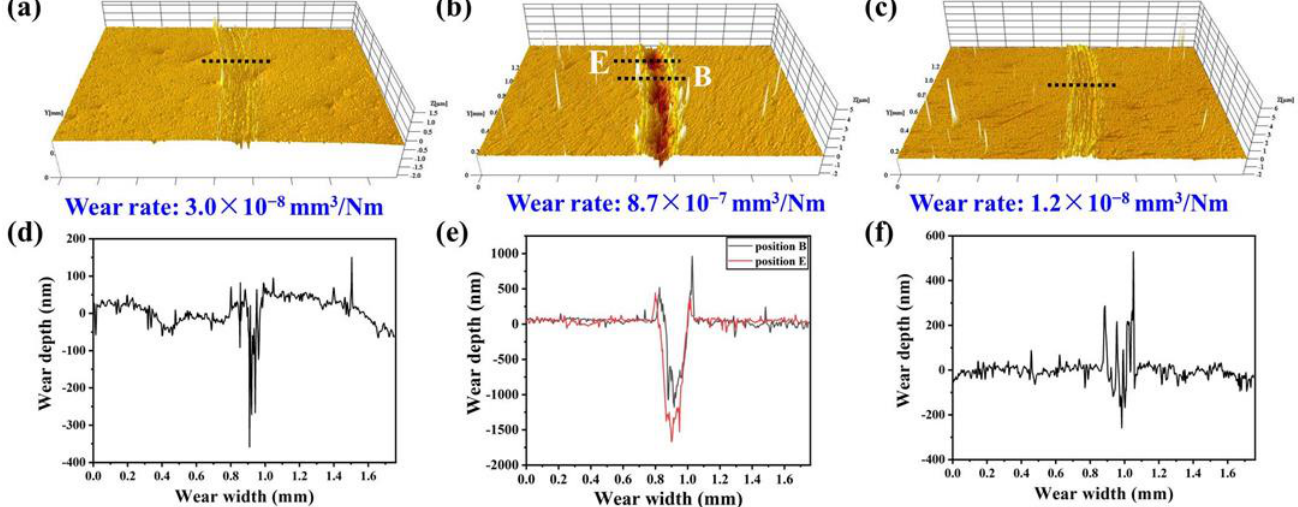
Figure 6. 3D images and depth profile of worn surfaces for studied films: ( a , d ) NbN; ( b , e ) NbN-Ag; ( c , f ) NbN/NbN-Ag.